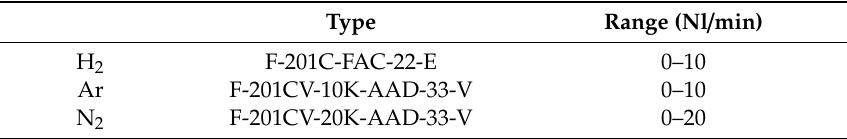
Table 2. Type and operation range of EL-FLOW PRESTIGE FG flow controllers.